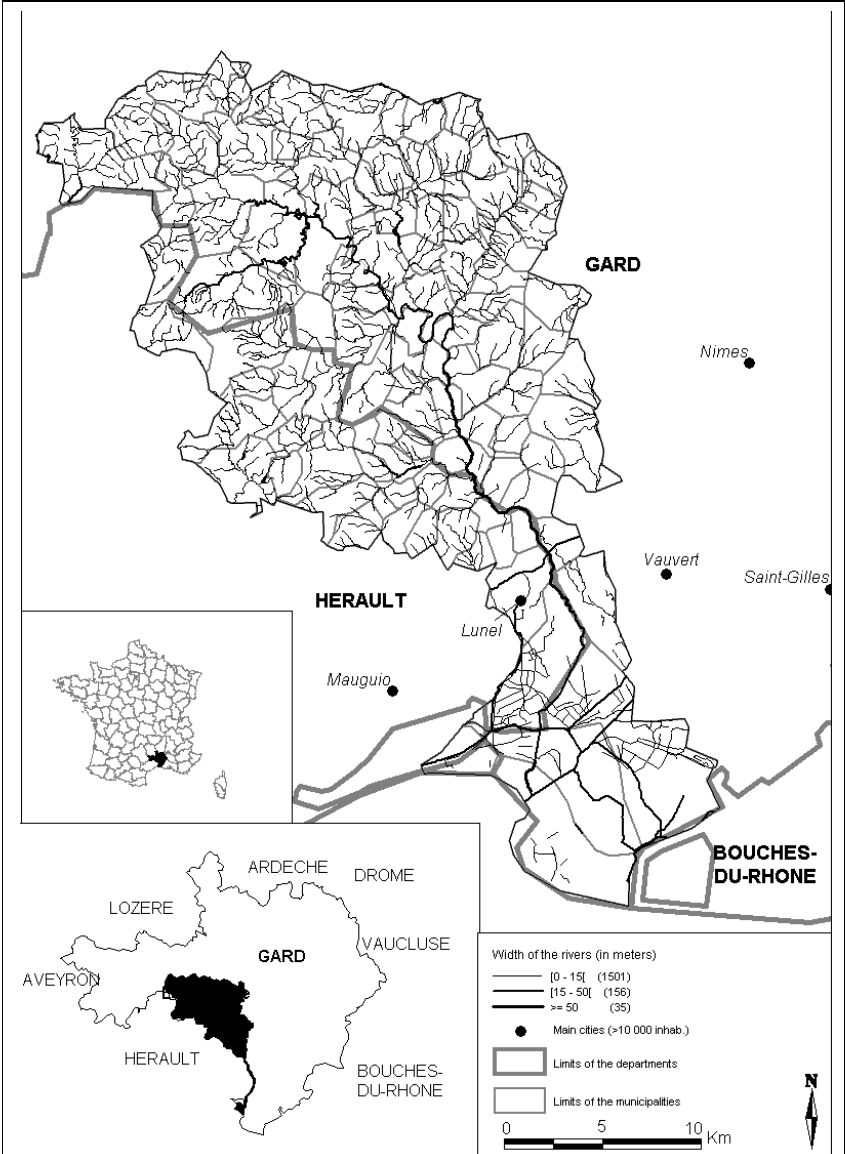
Fig. 1. Vidourle watershed